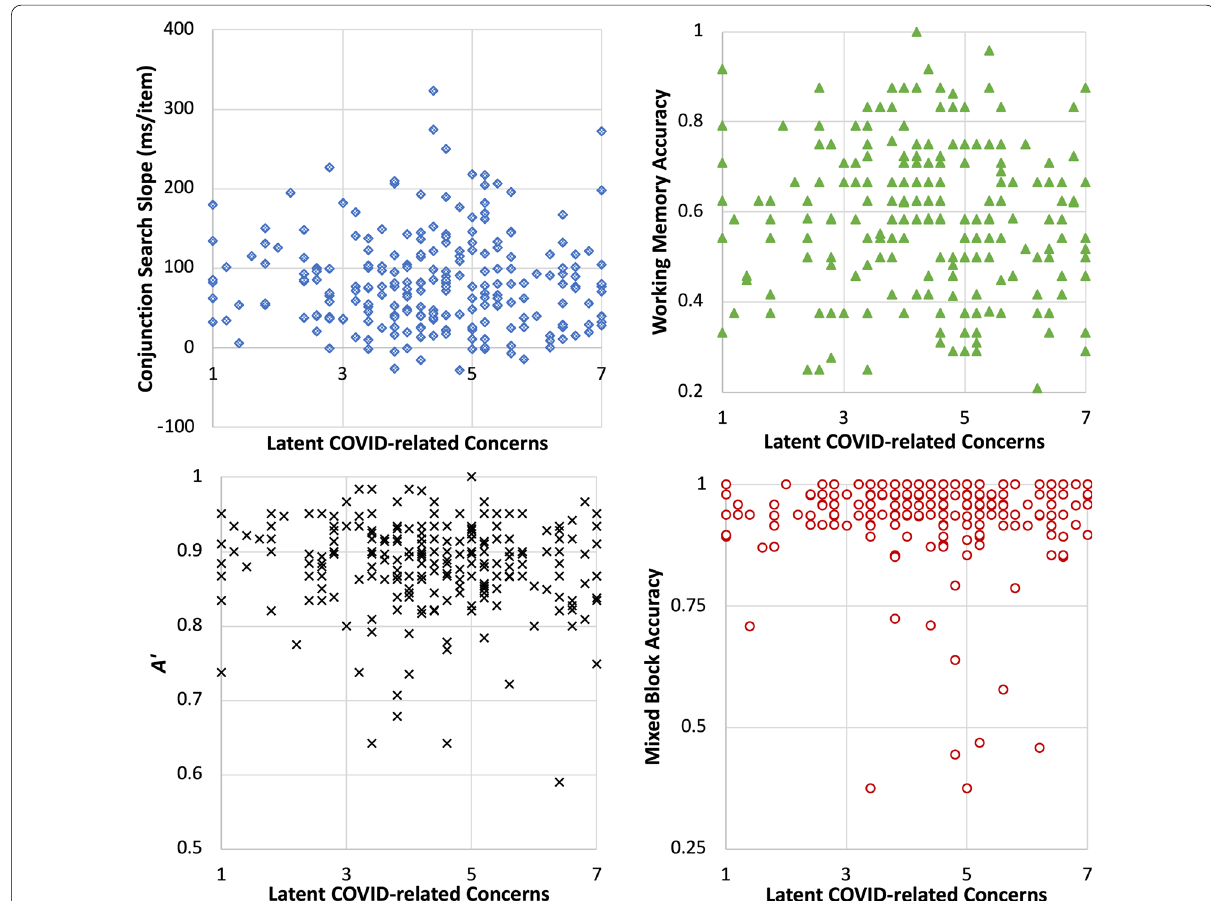
Fig. 4 Scatterplot illustrating the lack of correlation between task performance and the pre-task COVID-related concerns (the average of health and financial concerns). Top left: Scatterplot of visual search conjunction search slope versus pre-task COVID-related concerns. Top right: Scatterplot of working memory accuracy versus pre-task COVID-related concerns. Bottom left: Scatterplot of A ′ in scene CPT versus pre-task COVID-related concerns. Bottom right: Scatterplot of mixed-block accuracy in task switching versus pre-task COVID-related concerns